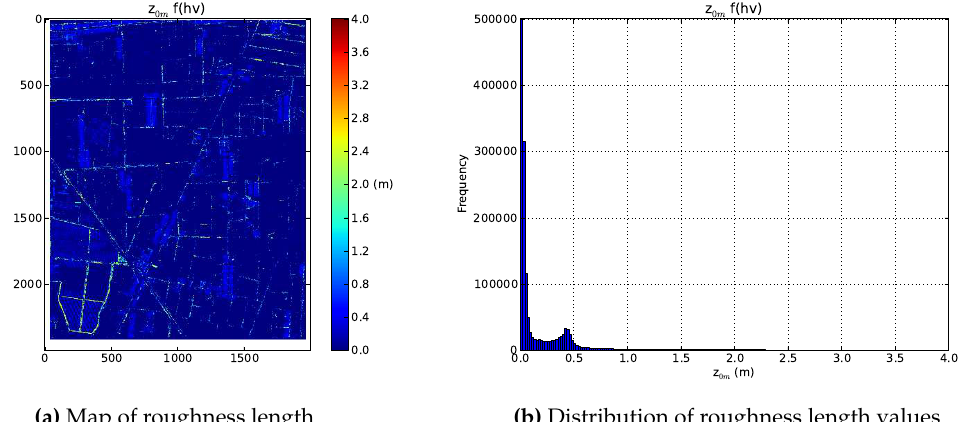
Figure 4. ( a ) Map and ( b ) frequency distribution of roughness length for momentum transfer values over the Yingke oasis station following Brutsaert’s